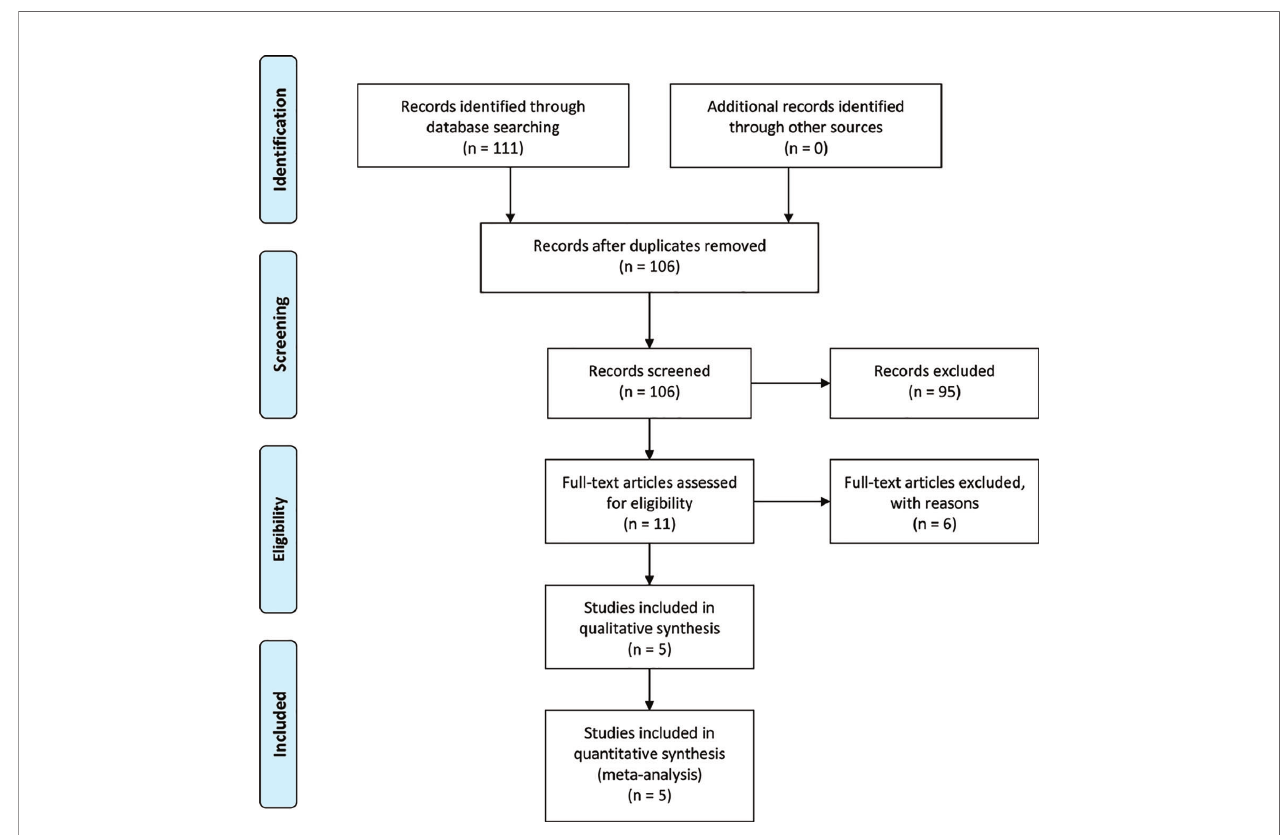
FIGURE 1 | A fl ow diagram of the literature search and selection